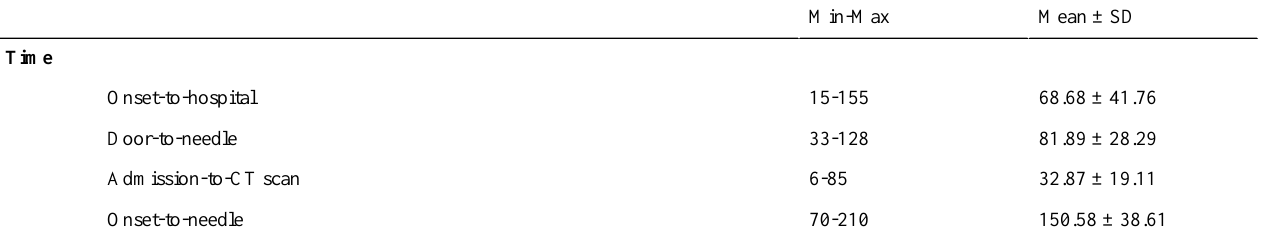
Table 3. Indicators in process of fibrinolysis delivery.